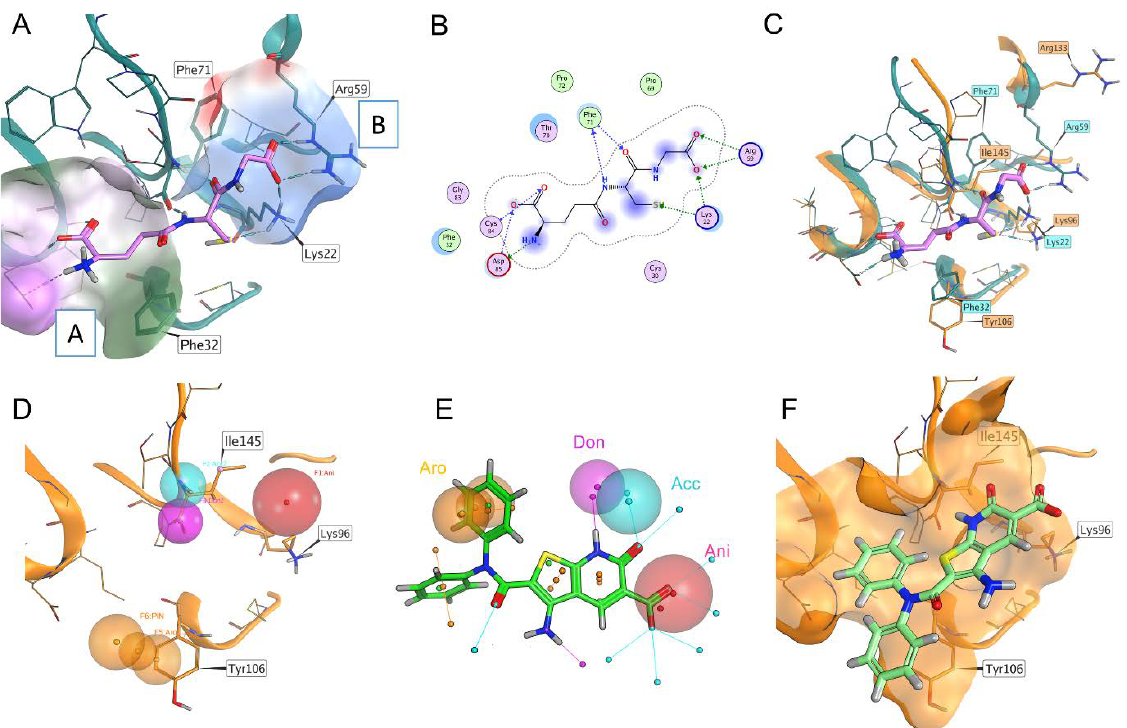
Figure 1. Panel ( A ): Experimental binding pose of GSH in Grx4 (From Escherichia coli ). Surface patch A is colored according to lipophilic potential, where green is more lipophilic and purple is more hydrophilic. Surface patch B is colored according to electrostatic potential, where blue is positively charged and red negatively charged. Panel ( B ): Schematic representation of the experimental binding mode reported in Panel ( A ). Blue arrows are hydrogen bonds, green arrows are charge–charge interactions, blue highlights on the ligand’s atoms are exposed solvent. Panel ( C ): Superposition of the glutathione binding site in 1CGrx1 (orange) and Grx4 (light blue); the experimental binding pose of glutathione in Grx4 is also reported (purple). Panel ( D ): The pharmacophore model. Red sphere: negatively charged group. Purple sphere: hydrogen bond donor with the backbone of Ile145. Light blue sphere: hydrogen bond acceptor with the backbone of Ile145. Orange spheres: position and orientation in space of aromatic groups , forming a π – π stacking with the side chain of Tyr106. Panel ( E ): The superimposition of the pharmacophoric model with compound 1. Panel ( F ): Pose of compound 1, T.b. 1CGrx1; the solvent-accessible surface is represented in orange.